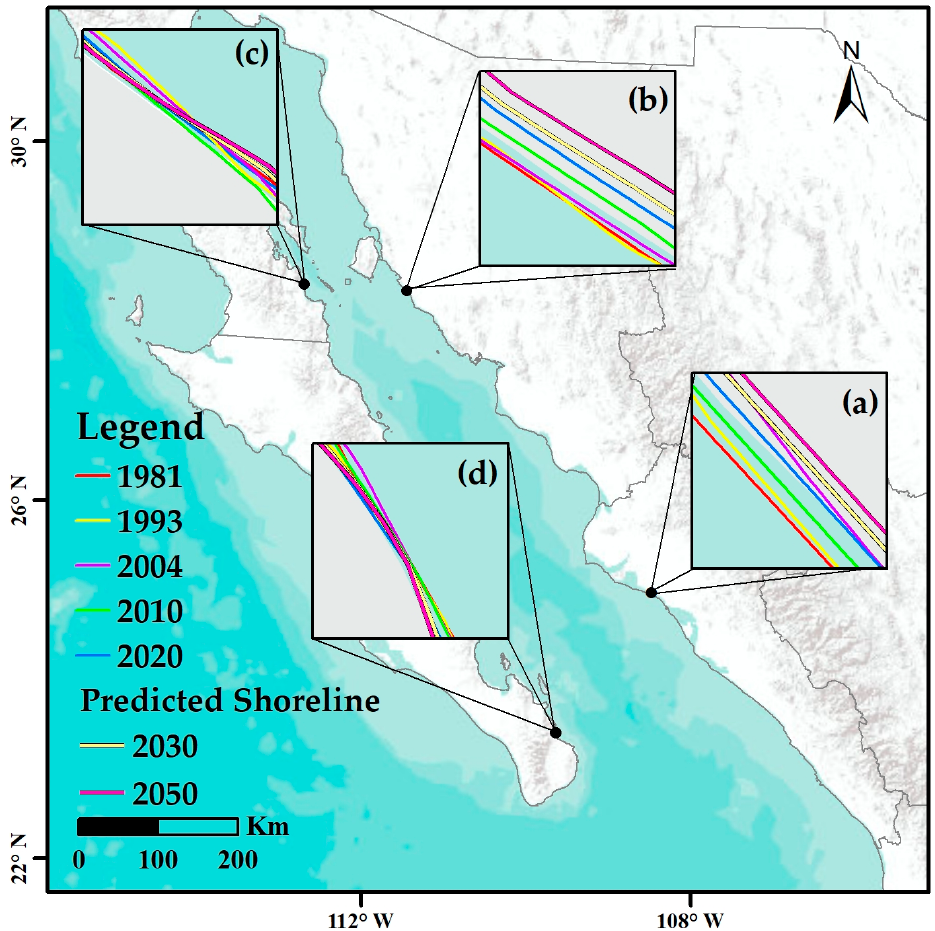
Figure 9. Current shoreline (2020) and forecast shorelines for 2030 and 2050, ( a ) Sinaloa, ( b ) Sonora, ( c ) Baja California, and ( d ) Baja California Sur.